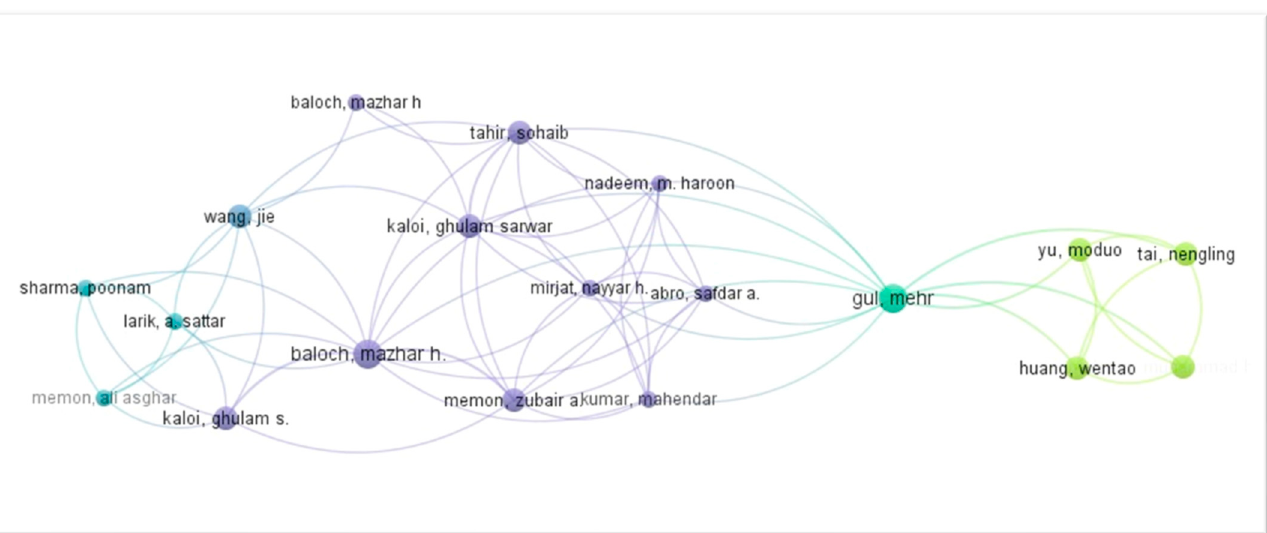
Figure 9. Co-citation network by authors.